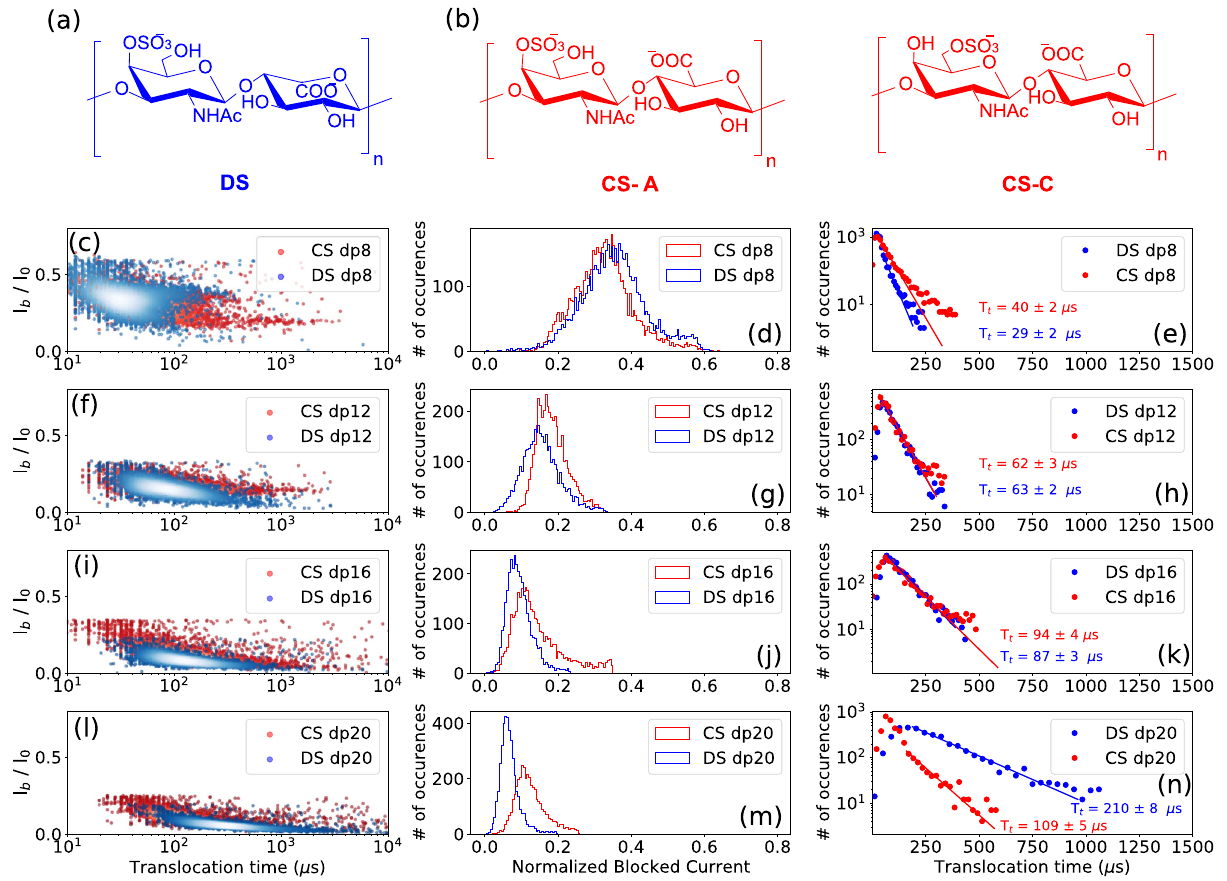
Fig. 6 | Probing the effect of GlcA / IdoA epimerization on the translocation behavior of the GAGs. Structure of a dermatan sulfate (DS) and b chondroitin sulfate (CS) A and C. Superimposed scatter plots of the c DS dp8 and CS dp8 f DS dp12 and CS dp12, i DS dp16 and CS dp16, and l DS dp20 and CS dp20. Super- imposed I b histogramsofthe d DSdp8andCSdp8 g DSdp12andCSdp12, j DSdp16 andCSdp16,and m DSdp20andCSdp20.Superimposed T t histogramsofthe e DS dp8andCSdp8, h DSdp12andCSdp12, k DSdp16andCSdp16,and n DSdp20and CS dp20. Slightly deeper current blockades are observed for DS oligosaccharides